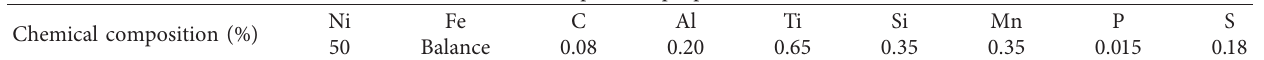
Figure 1: EDM machine (CHMER Table 1: Chemical composition properties of Inconel 718.